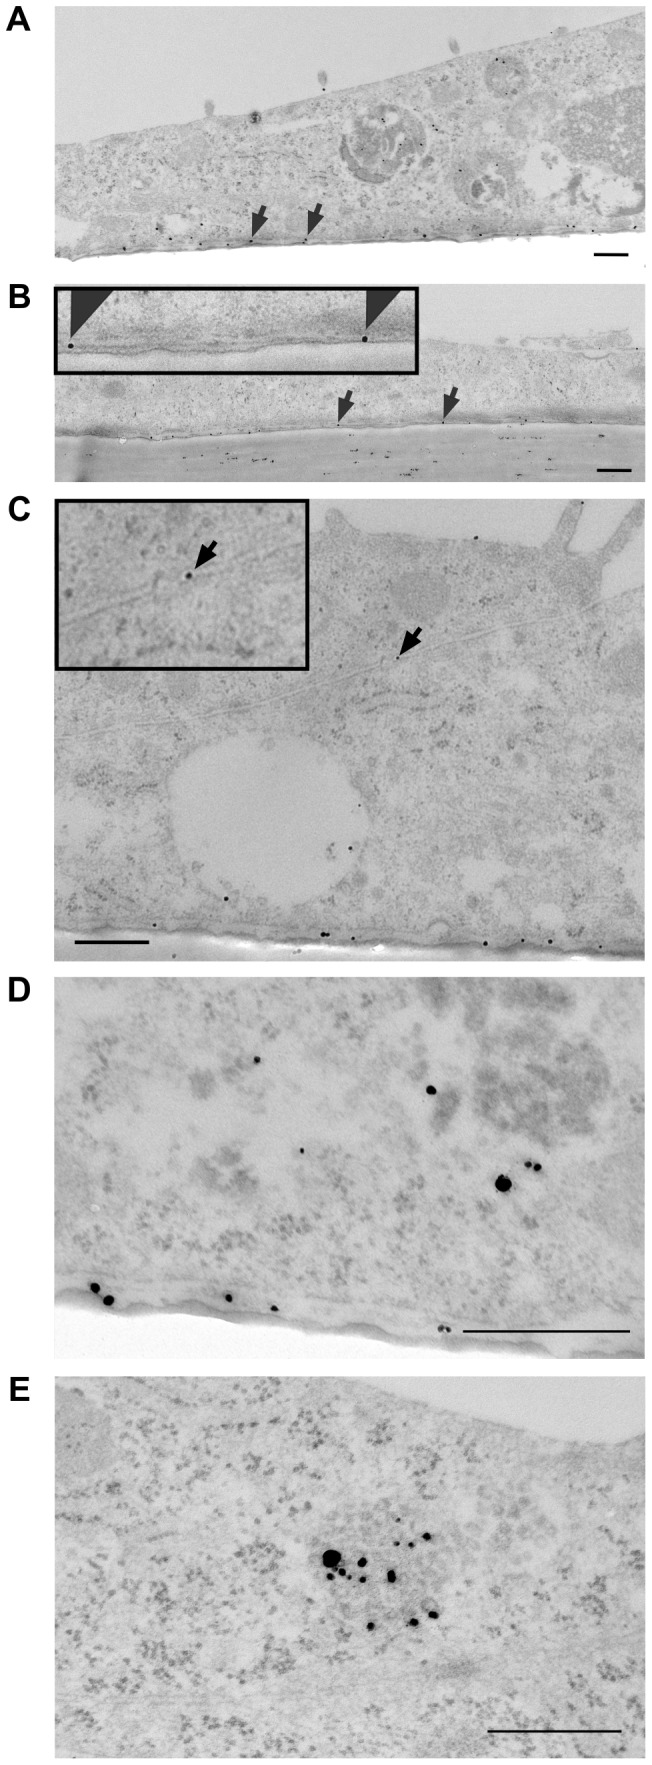
Electron micrographs of brain endothelial cells with glucose-coated gold nanoparticles.(a) hCMEC/D3 cells and (b) primary human brain endothelium 8 hours after application of glucose-nanoparticles to the apical surface. Nanoparticles are located between the basal plasma membrane and the transwell insert (arrows), for (b) the lower area is also magnified in the top left corner ×2. (c) A gold nanoparticle in the intercellular junction of hCMEC/D3 cells (arrow) 3 hours after application of nanoparticles to the apical surface (detailed magnification of the junction with nanoparticle is in the top left corner ×7). The nanoparticles are also seen in the cytosol and vesicles. (d) Detail of nanoparticles located in the cytosol and beneath the basal membrane. (e) Detail of nanoparticles in a vesicle. Scale bars = 500 nm.